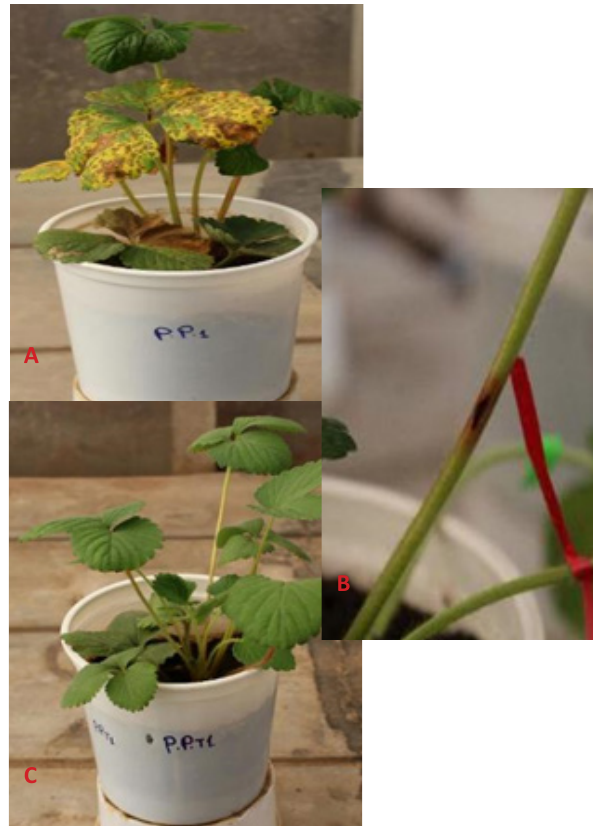
Figure 5. Disease symptoms in strawberry ( Fragaria ananassa ) plants. A) Strawberry plant showing necrotic spots and yellowing at 11 days after inoculation with Corynespora. cassiicola . B) Symptoms of leaf spot on the petiole. C) Uninoculated control